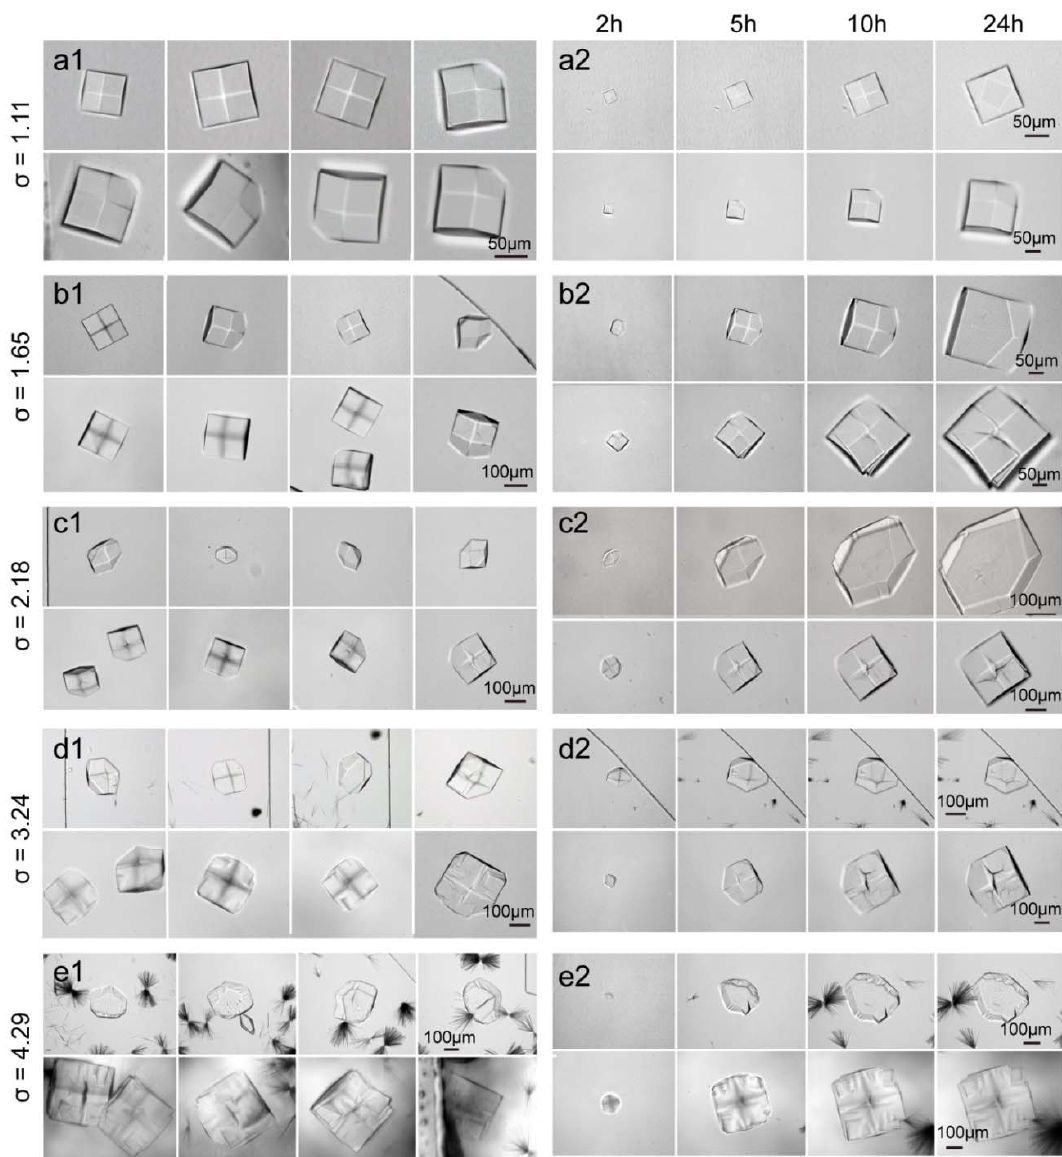
Figure 3. The morphologies of crystals grown in the microchannel and the sample pool. The experimental conditions are as shown in Table 1. In each set of experimental data, the morphologies of crystals grown in the microchannel were above and the morphologies of crystals grown in the sample pool were below. ( a1 – e1 ) shows the morphologies of the crystals grown in the microfluidic device and in the sample pool with different initial supersaturations at a specific time after the mixing of the NaCl solution and the clear lysozyme solution. The photo shoot time after the mixing of the NaCl solution and the clear lysozyme solution: ( a1 ): 10 h; ( b1 ): 10 h; ( c1 ): 5 h; ( d1 ): 5 h; ( e1 ): 24 h. ( a2 – e2 ) shows the morphology evolutions of the crystals grown in the microfluidic device and in the sample pool.